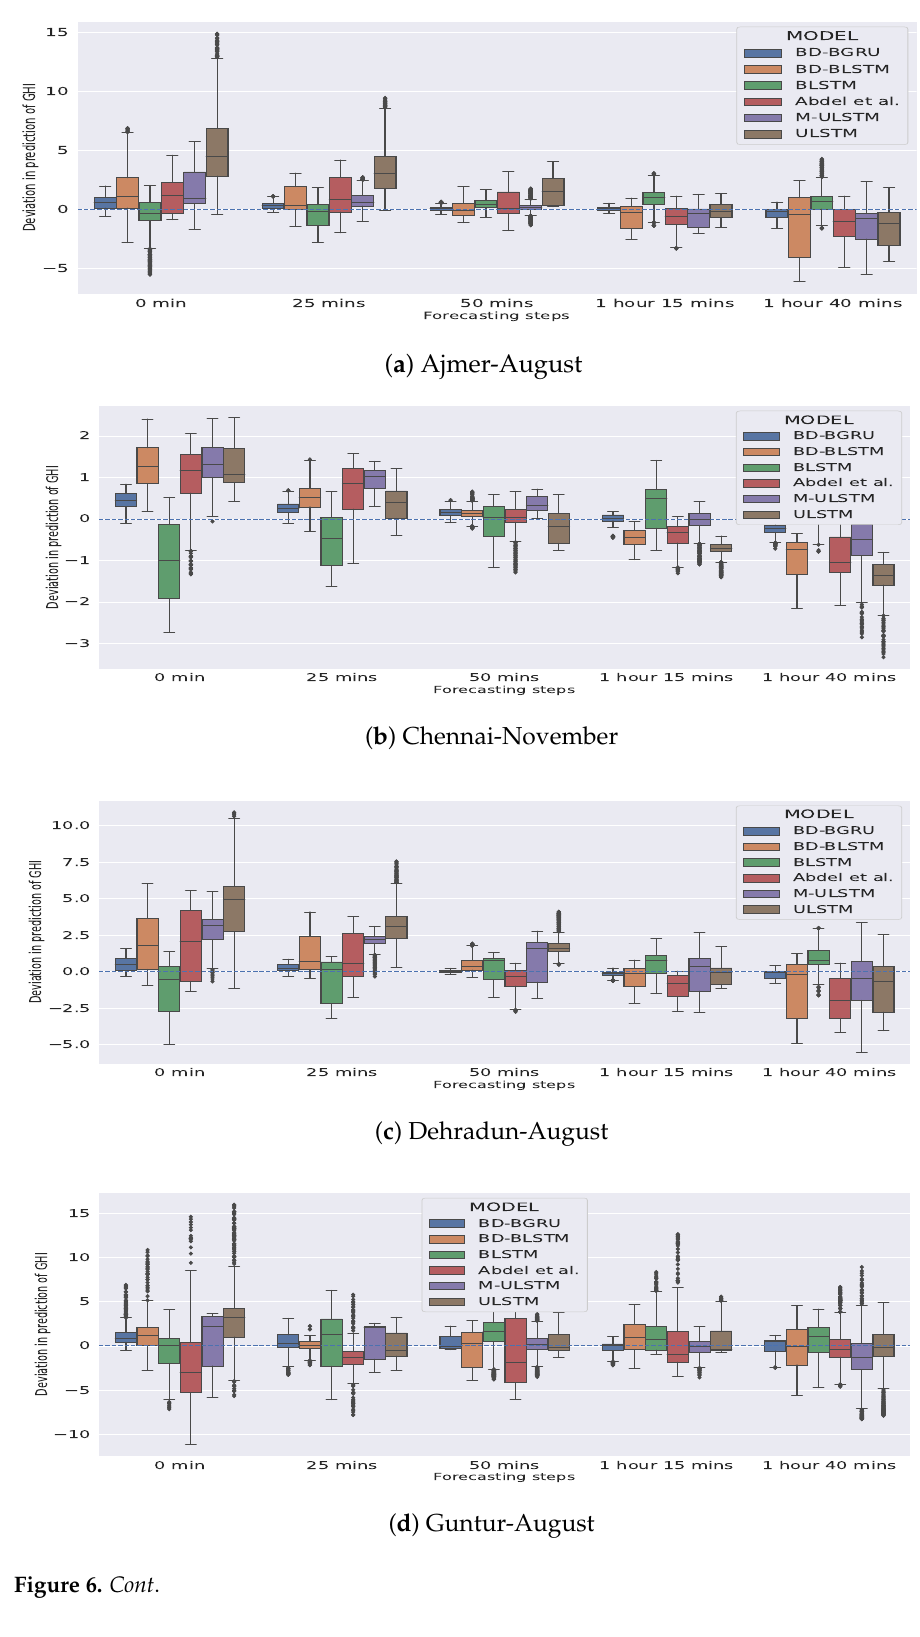
Figure 5. Variability in deviation of GHI ( W / m 2 ) in winter season.